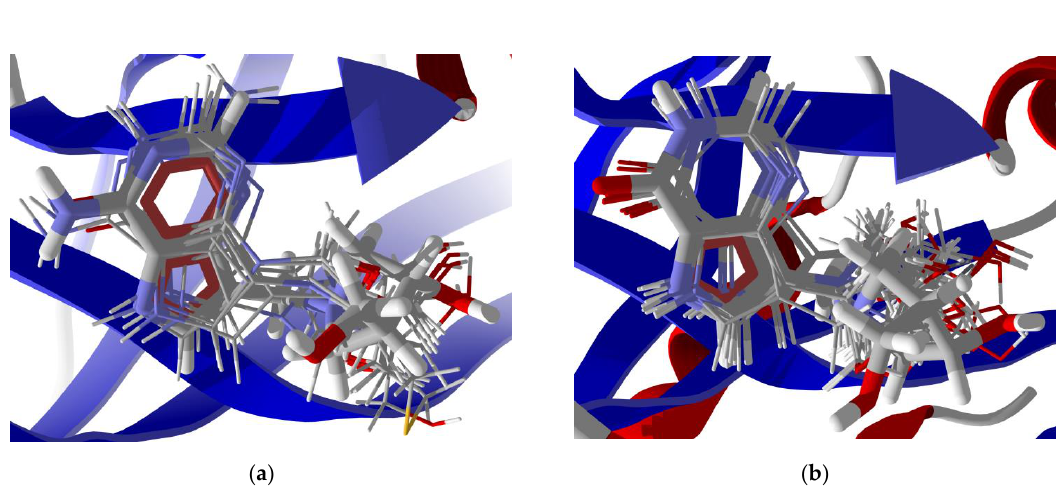
Figure 8. Lowest-energy docked poses of synthetic purine nucleoside phosphorylase inhibitors: ( a ) Trichomonas vaginalis purine nucleoside phosphorylase inhibitors [29,53] with TvPNP (PDB: 2ISC [29]; the docked ligands are shown as thin stick figures, while the co-crystallized ligand is shown as a thick stick figure. ( b ) Human purine nucleoside phosphorylase inhibitors [52] with HsPNP (human purine nucleoside phosphorylase) (PDB: 3BGS [33]), the docked ligands are shown as thin stick figures, while the co-crystallized ligand is shown as a thick stick figure.